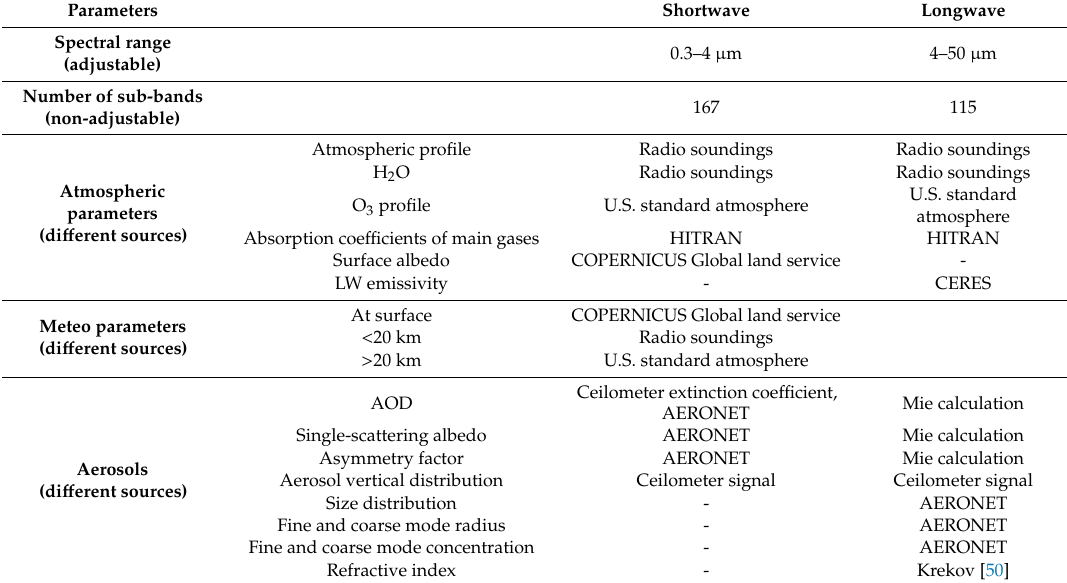
Table 2. Input parameters for the GAME model and data sources in the SW and LW spectral ranges. Note that the sources of the input and some parameters can be adjusted depending on the characteristics of the